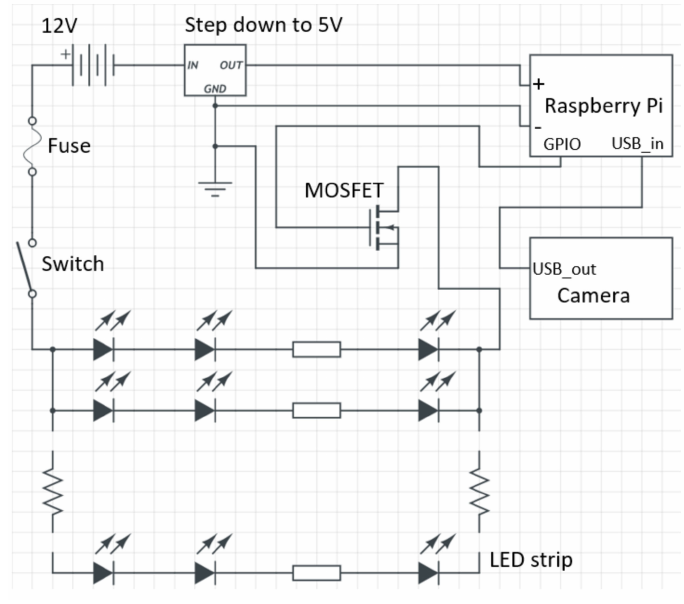
Figure 1. Schematic of the in-car camera unit.